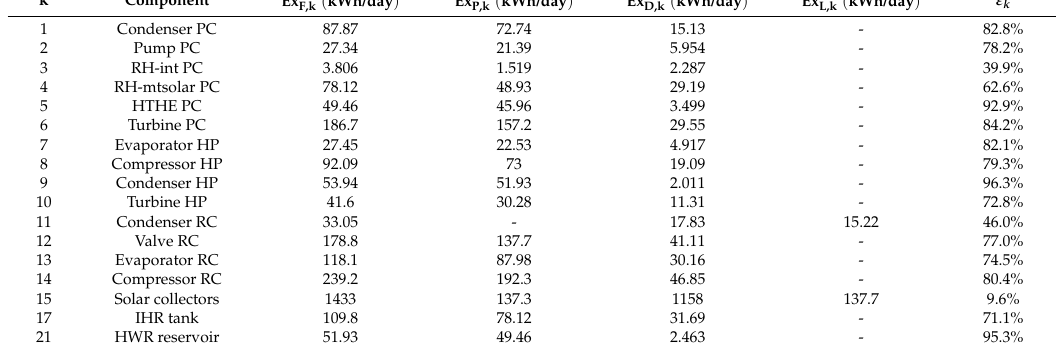
Table 7. Exergy analysis results for system operating on reference day of May in Crotone.